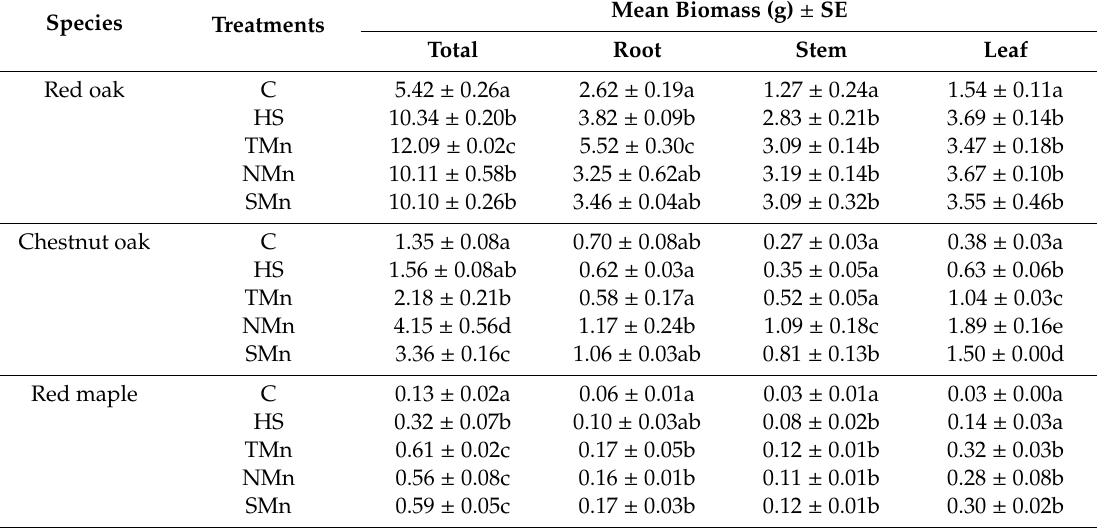
Table 3. Mean 1 dry biomass (g) of 12-week-old seedlings by species and component following treatments 2 of fertilizer with and without